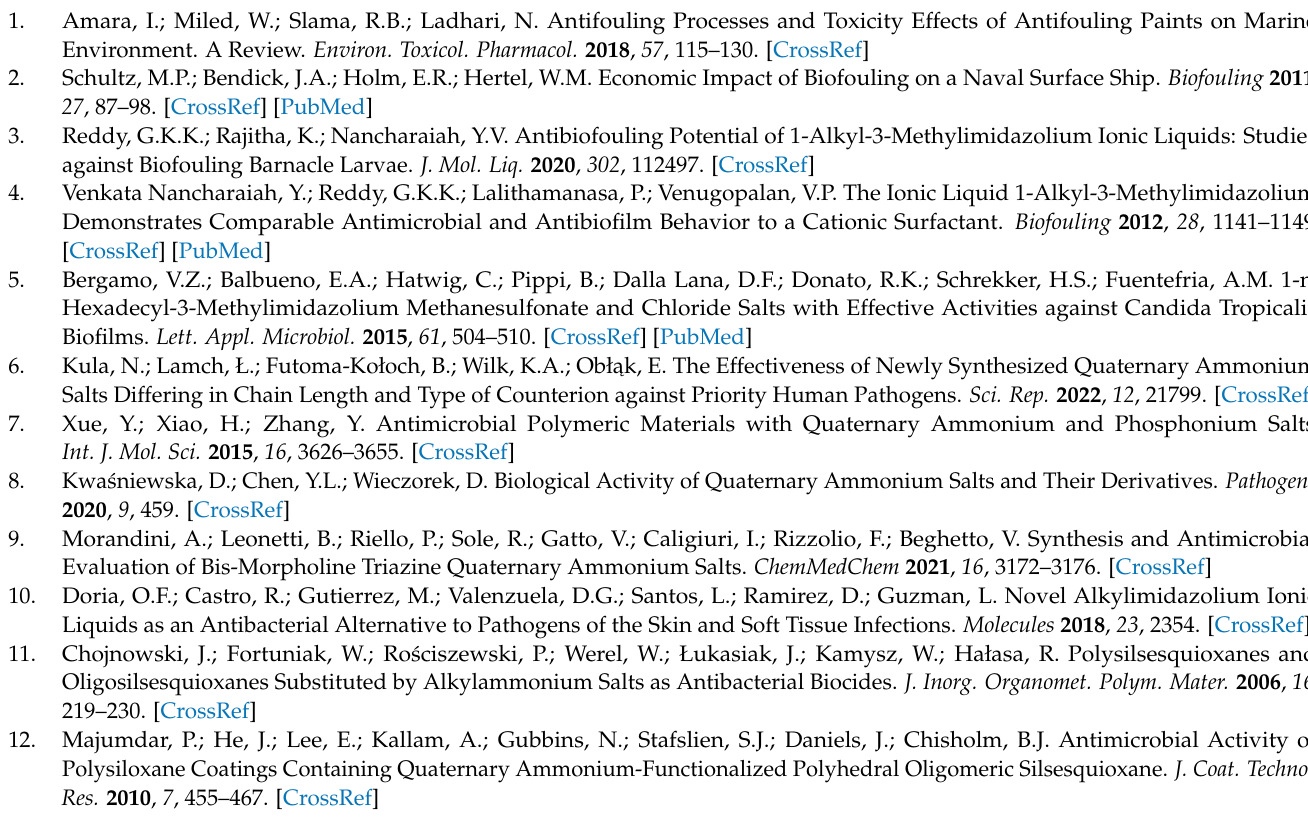
Figure S2. Mass spectra of tetra-substituted HQ-POSS. Figure S3. Mass spectra of tri-substituted HQ-POSS. Figure S4. Mass spectra of di-substituted HQ-POSS. Figure S5. Mass spectra of mono- substituted HQ-POSS. Figure S6. Adsorption–desorption isotherms of samples of HQ-POSS and materials. Figure S7. Pore size distribution of samples of HQ-POSS and materials. Figure S8. XRD patterns of the material 5CuTi and related reference ICSD